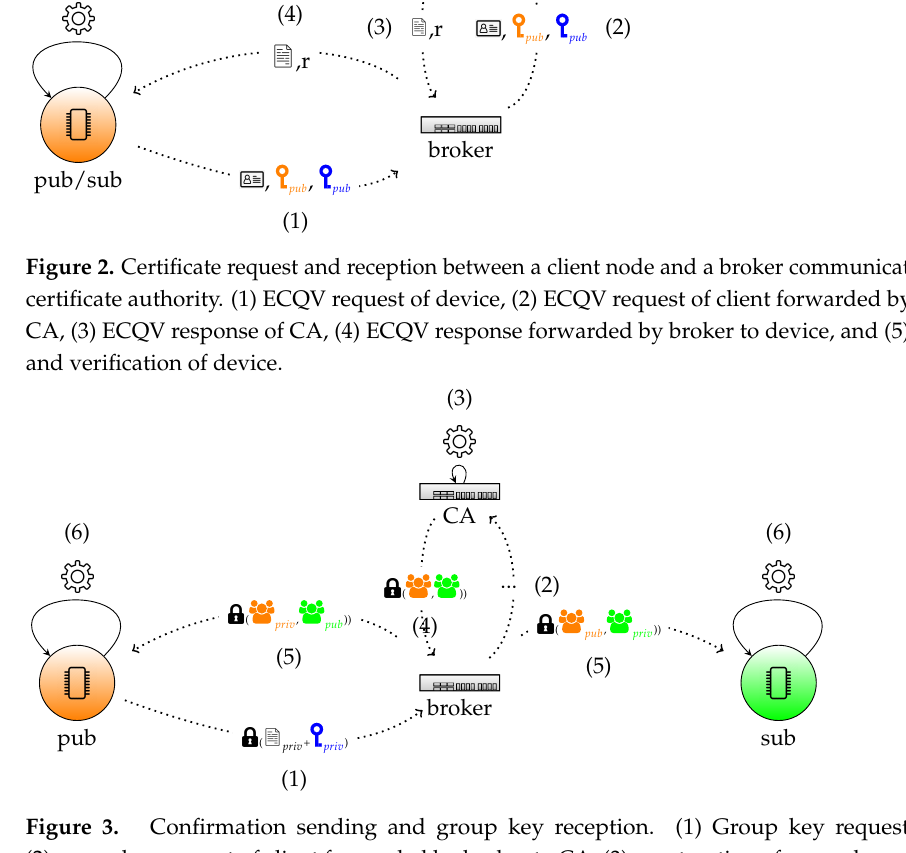
Figure 3. Confirmation sending and group key reception. (1) Group key request of client, (2)